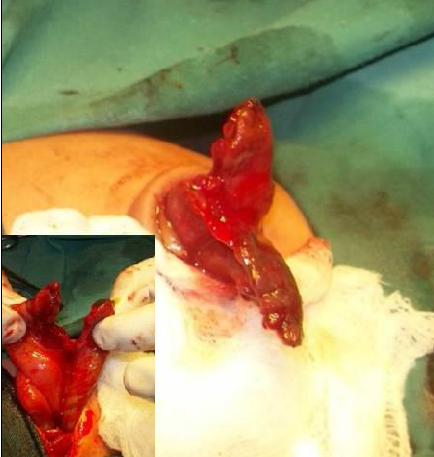
Figure 5: HUC with congenital loss of midgut. Inset shows rest over few inches of proximal jejunum and distal sigmoid colon. The rest of entire gut was lost. [3]